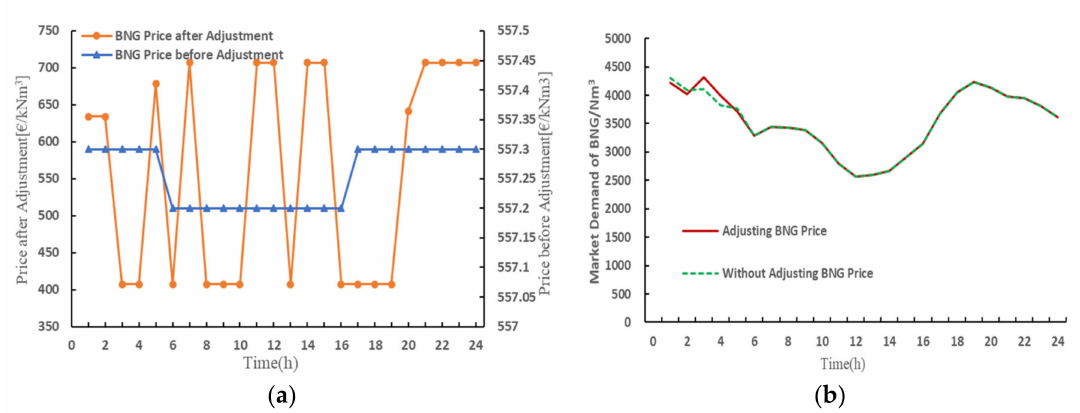
Figure 5. ( a ) A comparison chart of gas price in the day-ahead market; ( b ) a comparison chart of gas consumption before and after gas price adjustment in the day-ahead